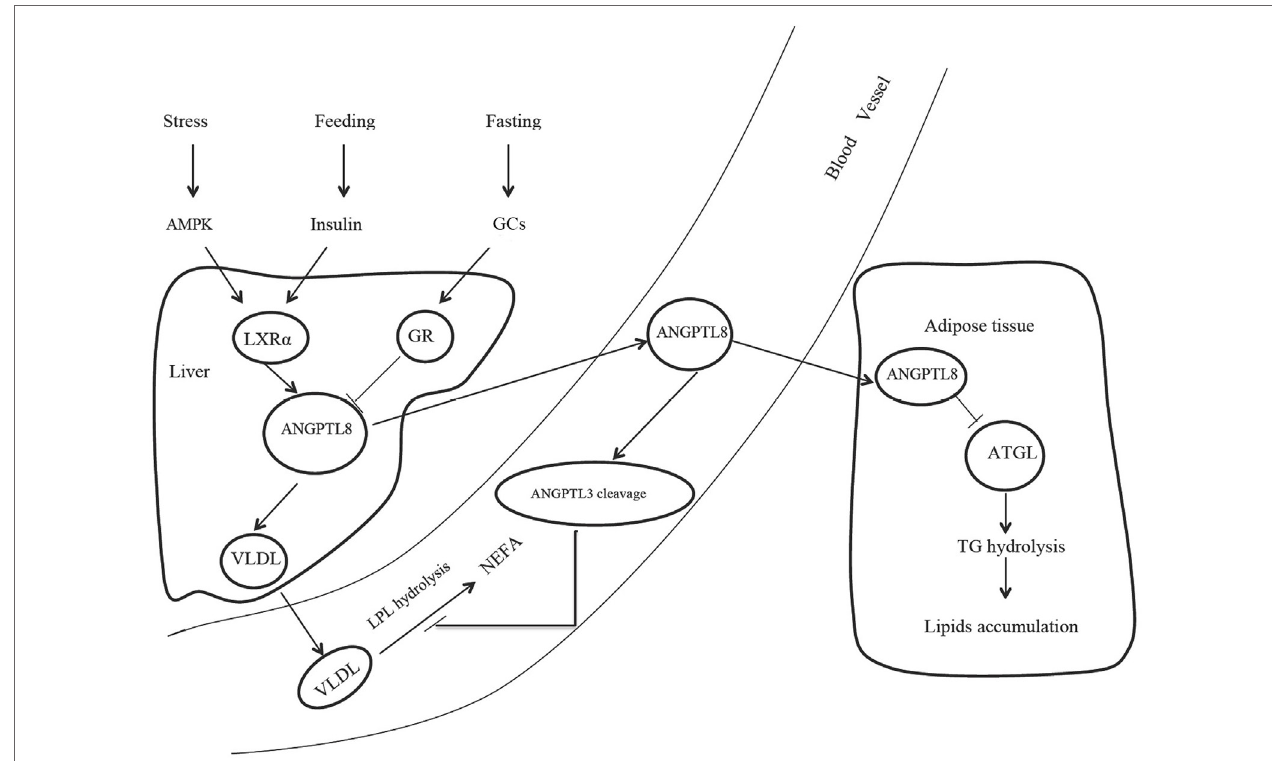
FiGURe 1 | The role of ANGPTL8 in lipids metabolism. AMPK, adenosine monophosphate-activated protein kinase; GCs, glucocorticoids; LXR α , liver X receptor α ; GR, glucocorticoid receptor; ANGPTL8, angiopoietin-like protein 8; VLDL, very low-density lipoprotein; LPL, lipoprotein lipase; NEFA, nonesterified fatty acid; ANGPTL3, angiopoietin-like protein 3; ATGL, adipose triglyceride lipase; TG,